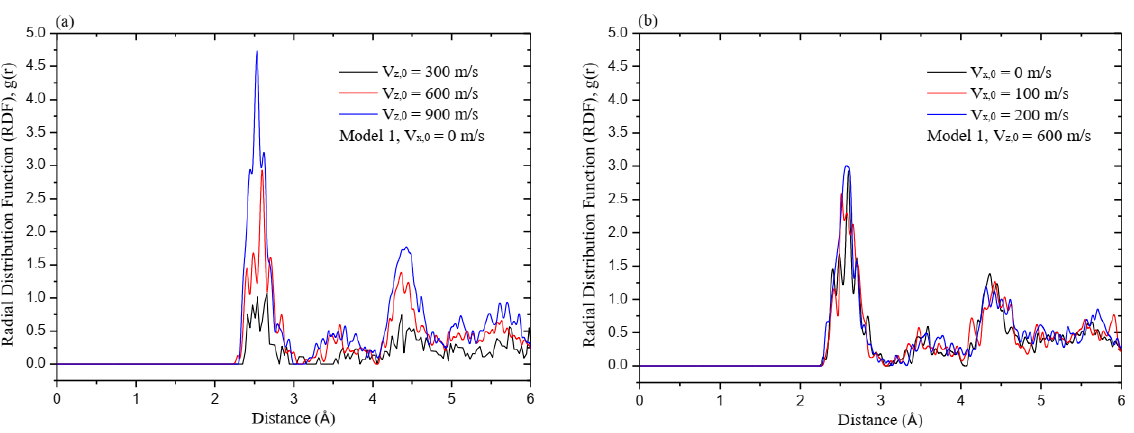
Figure 6. RDFs in Model 1: ( a ) V x ,0 = 0 m/s and various V z ,0 and ( b ) V z ,0 = 600 m/s and various V x ,0 .